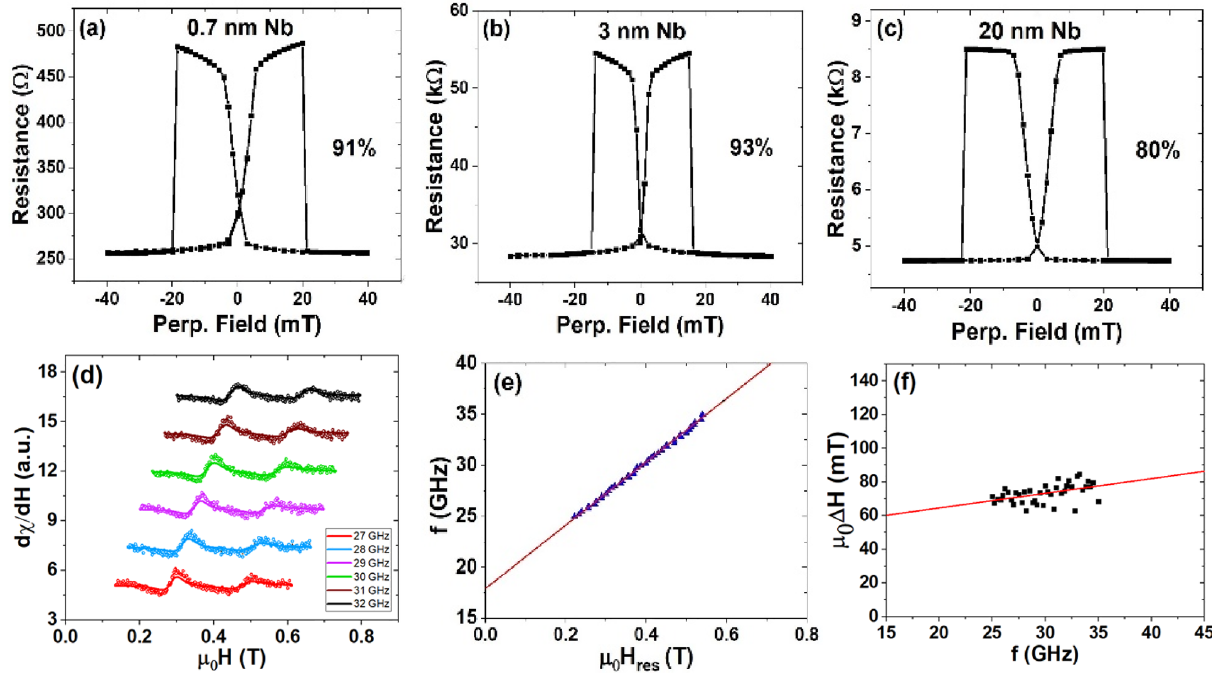
Figure 3. The TMRs of a series of pMTJs with ( a ) d 1 = 0.7 nm, d 2 = 1.18 nm; ( b ) d 1 = 3 nm, d 2 = 3 nm; ( c ) d 1 = 20 nm, d 2 = 10 nm; after being annealed at 300 °C for 10 min. ( d ) Ferromagnetic resonance (FMR) measurements in Nb-pMTJs with FMR frequencies between 27 and 32 GHz. ( e ) The fitting of the FMR frequency f versus frequency-dependent resonance field µ 0 H res . ( f ) The fitting of the linewidth µ 0 � H versus the FMR frequency f